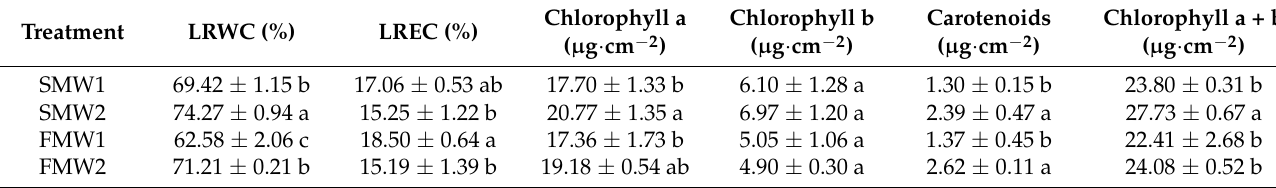
Figure 4. Effects of different treatments on tomato plant height ( A ), stem diameter ( B ), leaf number ( C ), leaf length ( D ), leaf width ( E ), and leaf area ( F ). Values are the mean ± SD (n = 3). Duncan’s multiple-range test was used to test for differences among treatments at the p < 0.05 level. Different lowercase letters above the columns indicate significant differences among treatments within the same day. Table 2. Relative water content (LRWC), relative electrical conductivity (LREC), chlorophyll a content, chlorophyll b content, carotenoids content, and chlorophyll a + b content of tomato leaves under different